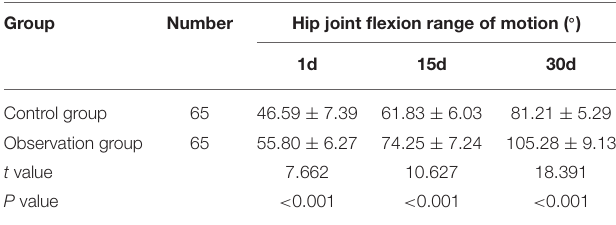
TABLE 2 | Comparison of flexion range of hip joint between two groups. Group